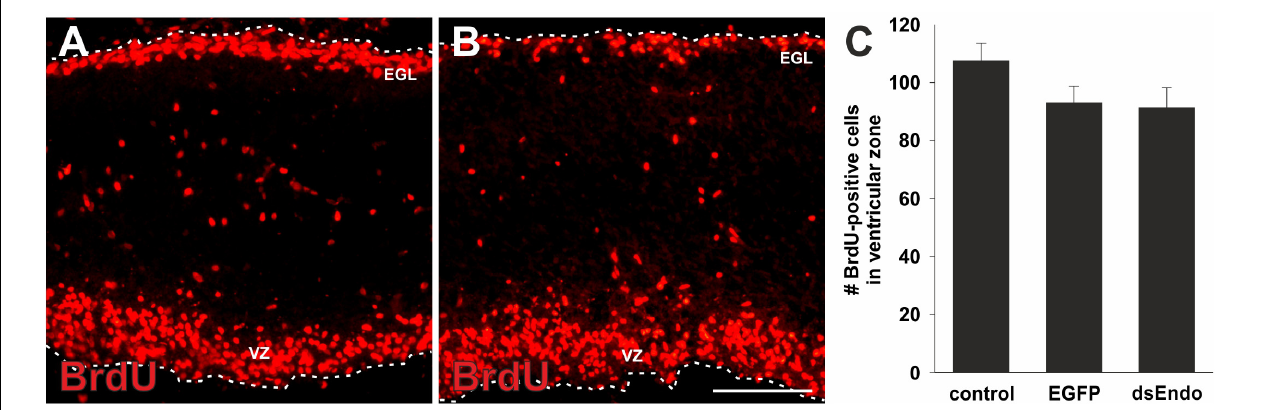
FIGURE 5 | The lack of proliferation in the absence of Endoglycan is specific for granule cells. To rule out a general effect of Endoglycan on cell proliferation, we also quantified the number of BrdU-positive cells in the ventricular zone (VZ). At HH35, there are many BrdU-positive cells in the external granule cell layer (EGL), but also in the ventricular zone. We found no significant difference in the number of proliferating cells in the ventricular zone in sections taken from controls (A) compared to embryos lacking Endoglycan (dsEndo; B , p = 0.1978 and 0.9873). Bar: 100 µ m. (C) We counted an average of 107.5 ± 6.1 cells in untreated embryos ( n = 7), 93.0 ± 5.7 cells in control-treated, EGFP-expressing embryos ( n = 3), and 91.3 ± 6.9 cells in dsEndo-treated embryos ( n = 5). One-way ANOVA with Tukey’s multiple comparisons test used for statistical